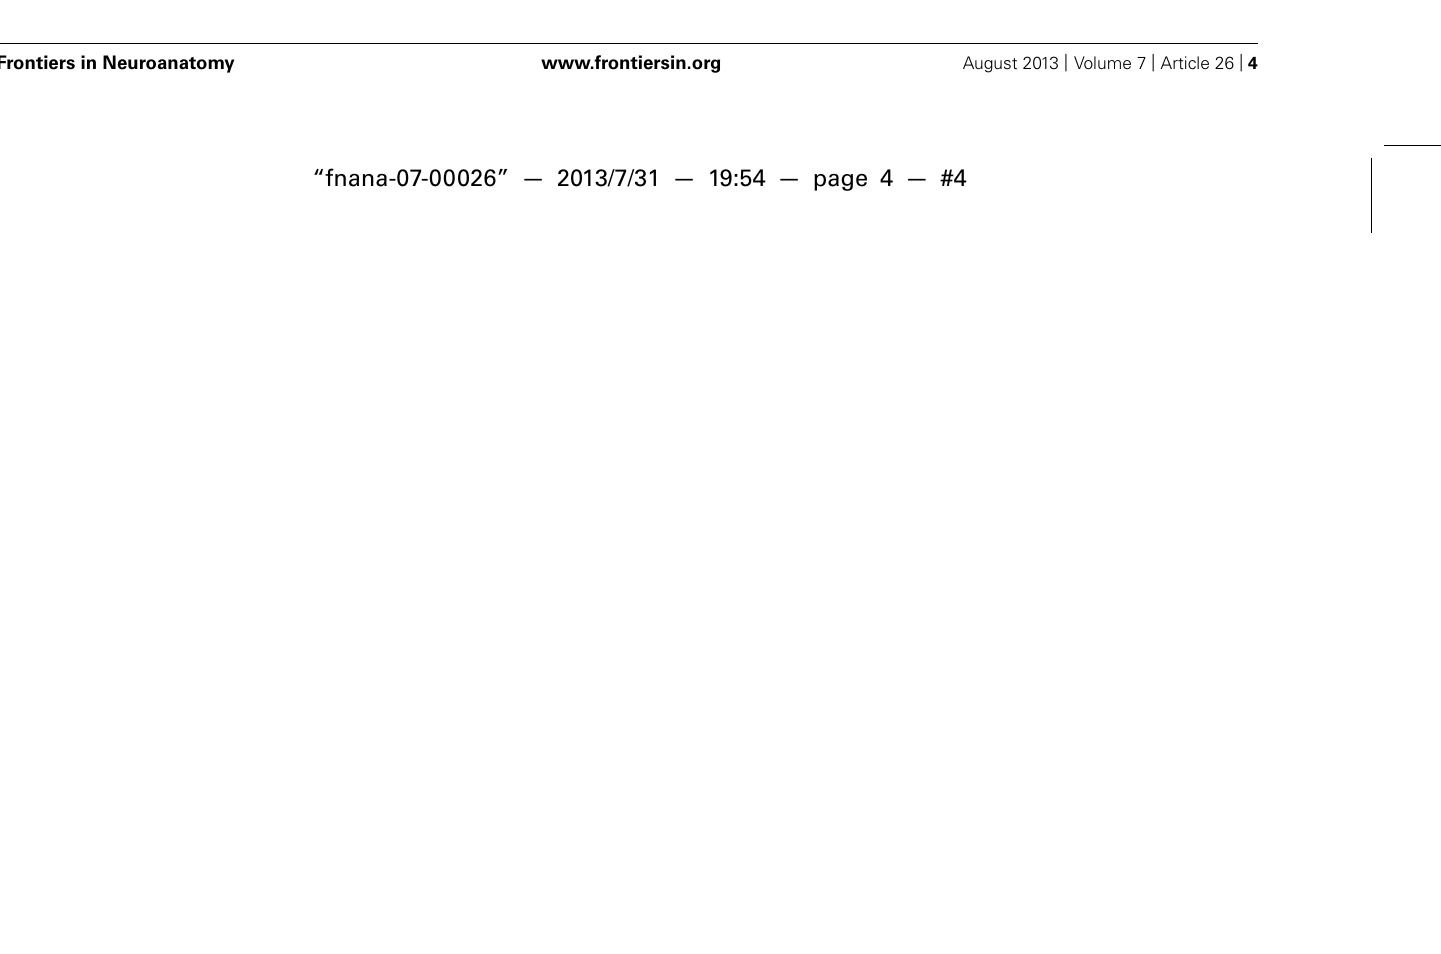
FIGURE 1 | (A) The calcarine sulcus.The calcarine sulcus cortex (red) ROI projected to the mesial surface of the left hemisphere. Following Brodmann’s demarcation of area 17, both banks were traced posterior to the intersection of the calcarine sulcus and the parieto-occipital sulcus (blue) (coronal slice a ), but only the lower bank of sulcus was traced anterior to this intersection (coronal slice b ). (B) Broca’s area (left hemisphere) of the inferior frontal gyrus divided into the pars triangularis (PTri, red) and pars opercularis (POp, blue). Regions of interest were defined and traced as described in Section “Materials and Methods,” following Keller etal. (2007). IFS, inferior frontal